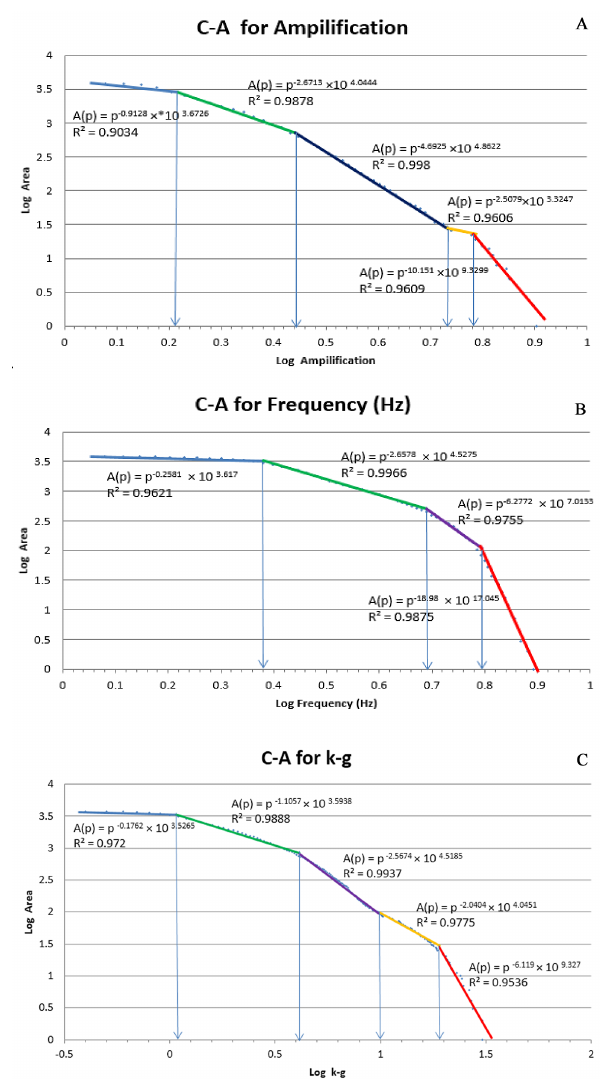
Figure 7. C – A log–log plot for the parameters: (a) frequency, (b) amplification, (c) K - g